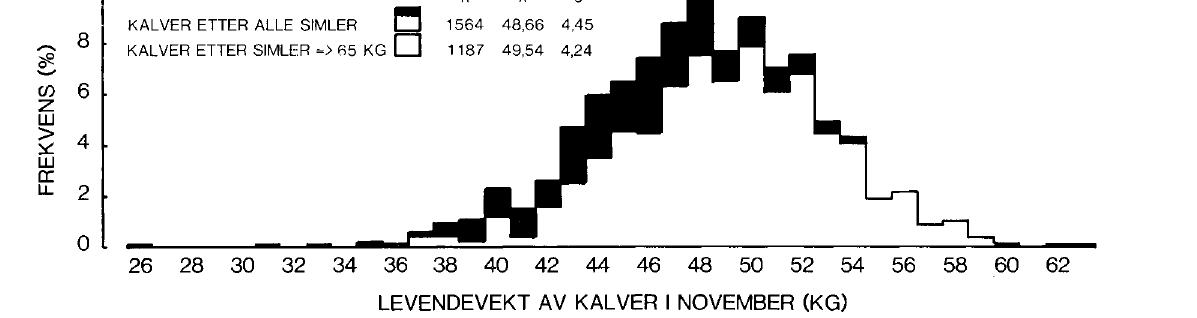
Figur 14. Vekt av kalver i Riast/Hylling-flokken i november 1984. Antall kalver innen vektklasser på hele kilo er angitt. Svart del markerer kalver etter mødre som er lettere enn 65 kg (Lenvik upubll).